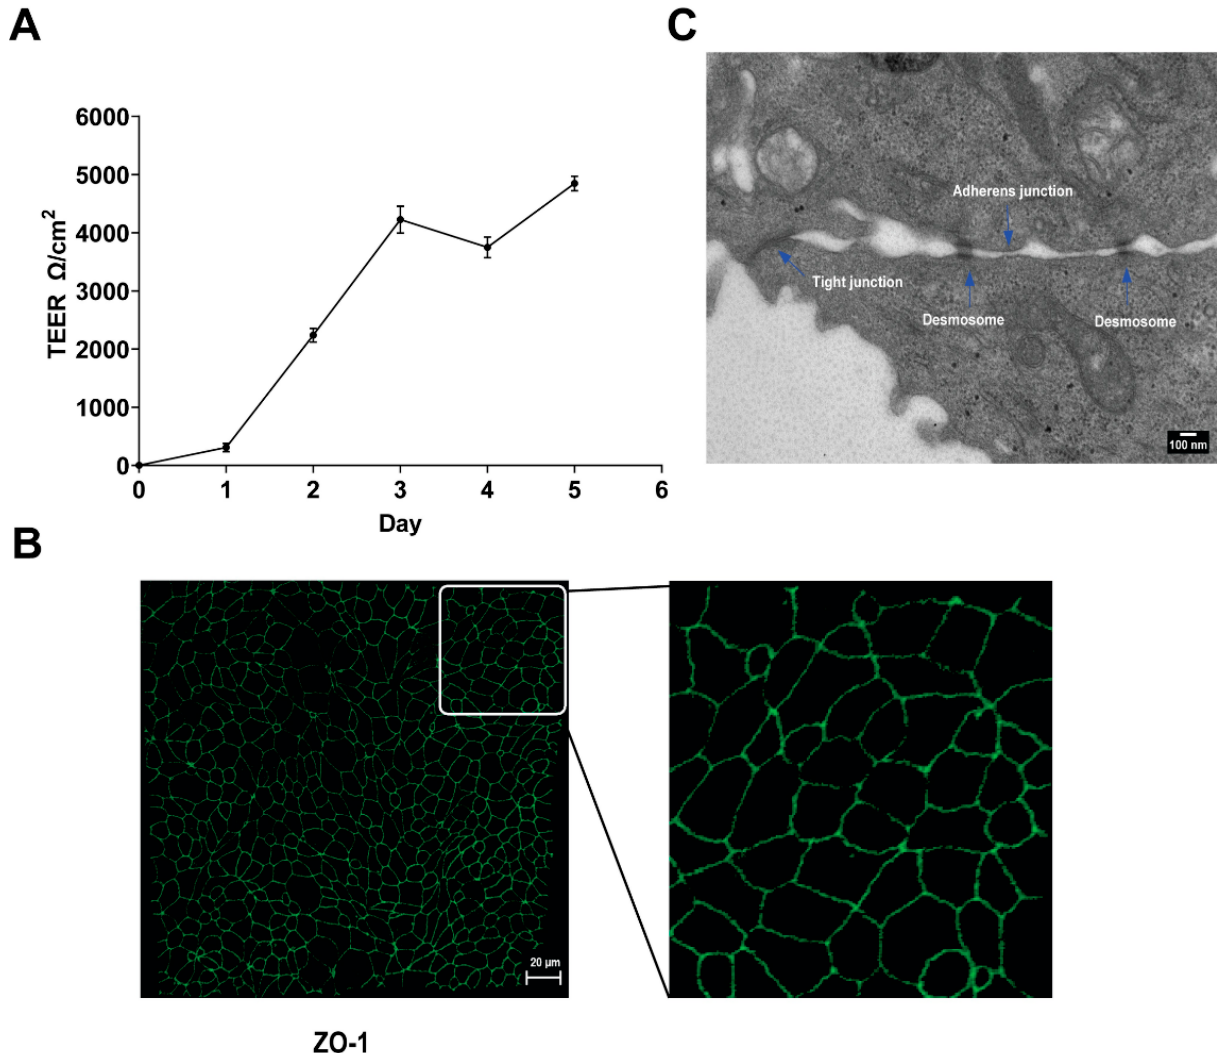
Figure 1. MDCK cell polarization. ( A ) Increase in value of transepithelial electrical resistance (TEER) measurements post-seeding. MDCK cells were seeded on 0.4 µm transwell cell culture inserts, and TEER was measured daily for five days after plating. Results are shown as the mean value ± SD. ( B ) Confocal image showing indirect IF staining for the tight-junction protein ZO-1 (green) expressed by polarized MDCK cells grown for five days on transwell cell culture inserts. The right-hand panel shows an enlargement of the section delineated by the white square. ( C ) Electron micrograph show- ing the junctional complex (tight junction, adherens junction, and desmosome) formed between po- larized MDCK cells at five days post-seeding.